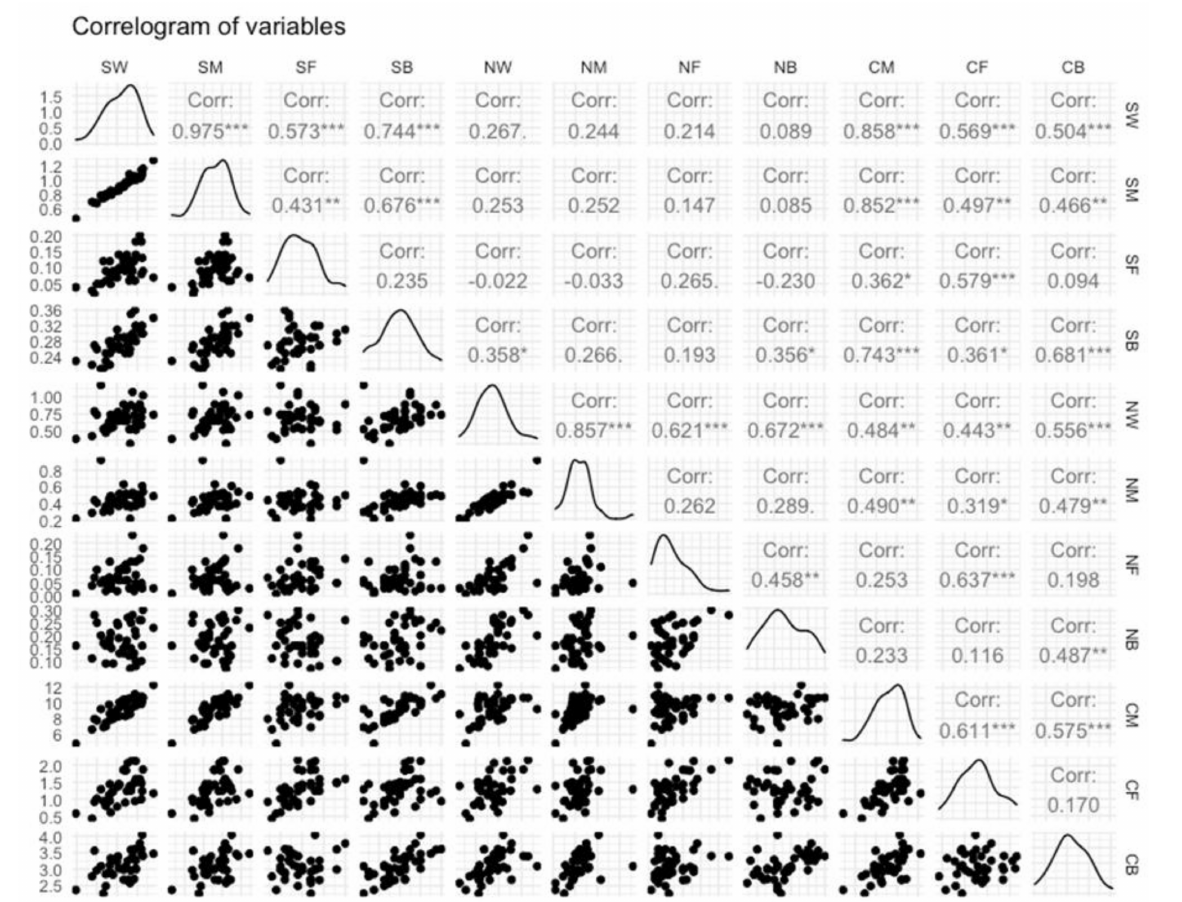
Figure 1. Graphical analysis of the input and output variables. Scatterplots, distributions, and correlation coefficients of shoulder weight (SW), shoulder muscle (SM), shoulder fat (SF), shoulder bone (SB), neck weight (NW), neck muscle (NM), neck fat (NF), neck bone (NB), carcass muscle (CM), carcass fat (CF), carcass bone (CB). *** p < 0.001; ** p < 0.01; * p <